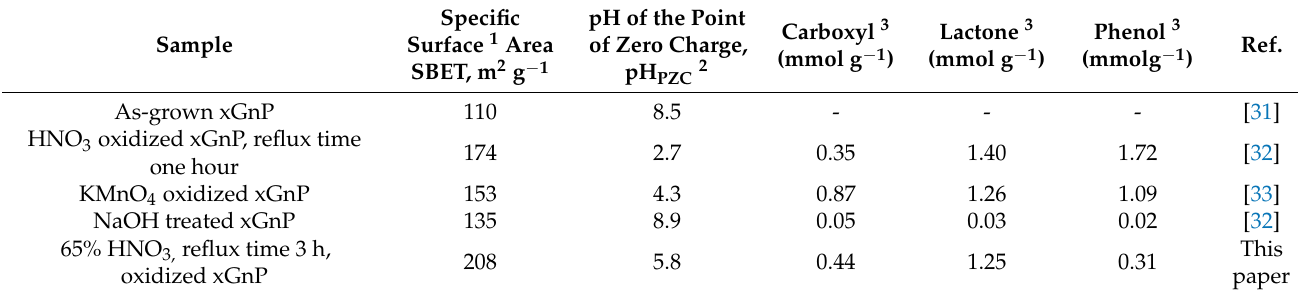
Table 2. Specific surface area, pH of the point of zero charge and the number of functional groups on the surface of oxidized xGnP (ox-xGnP) determined by Boehm